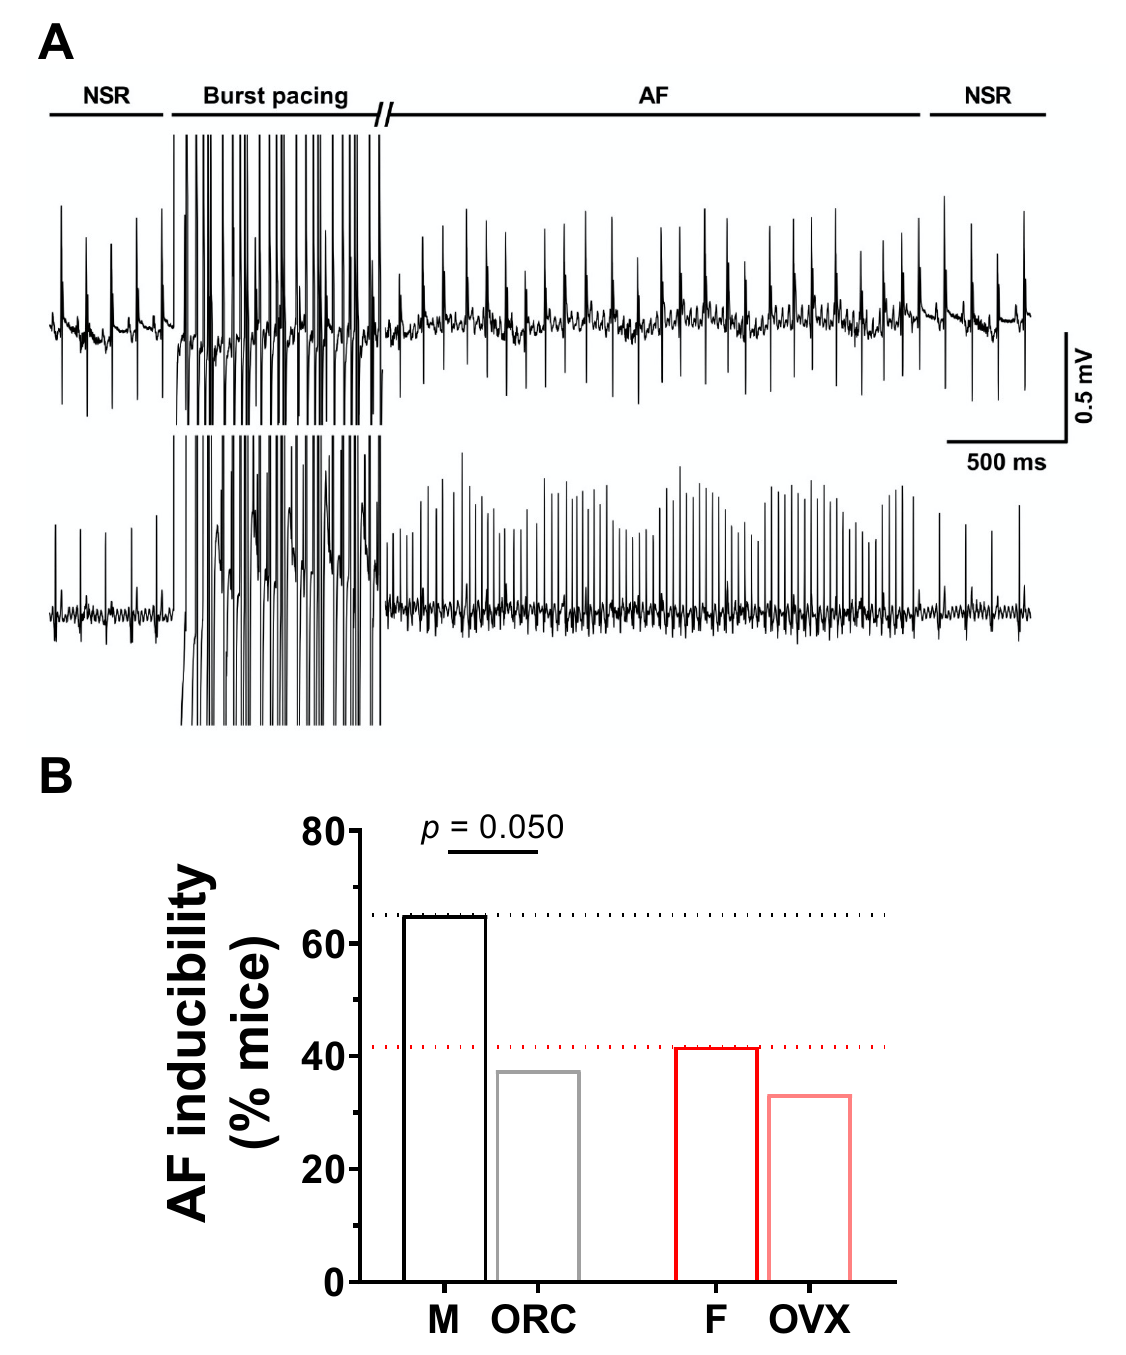
Figure 6. Orchiectomy reduces susceptibility of males to AF. ( A ). Typical recording of simultaneous surface ECG and intracardiac ECG (iECG) with induction of AF in response to burst pacing, followed by spontaneous recovery to NSR. The burst pacing duration has been cut for easier graphical illustration. ( B ). The bar graphs summarize data obtained on AF inducibility in intact and gonadectomized male and female mice in response to burst stimulation protocols (M: 65%, 13/20; ORC: 38%, 6/16; F: 42%, 10/24; OVX: 33%, 4/12). While ovariectomy has no effect on AF susceptibility in females, orchiectomy reduced AF susceptibility of males. The male and orchiectomized groups were compared using the one-sided chi square test ( p = 0.050). Data for intact male (M) and female (F) presented in panel B represent a subset of data of a separate study submitted to International Journal of Molecular Sciences (IJMS) (unpublish).